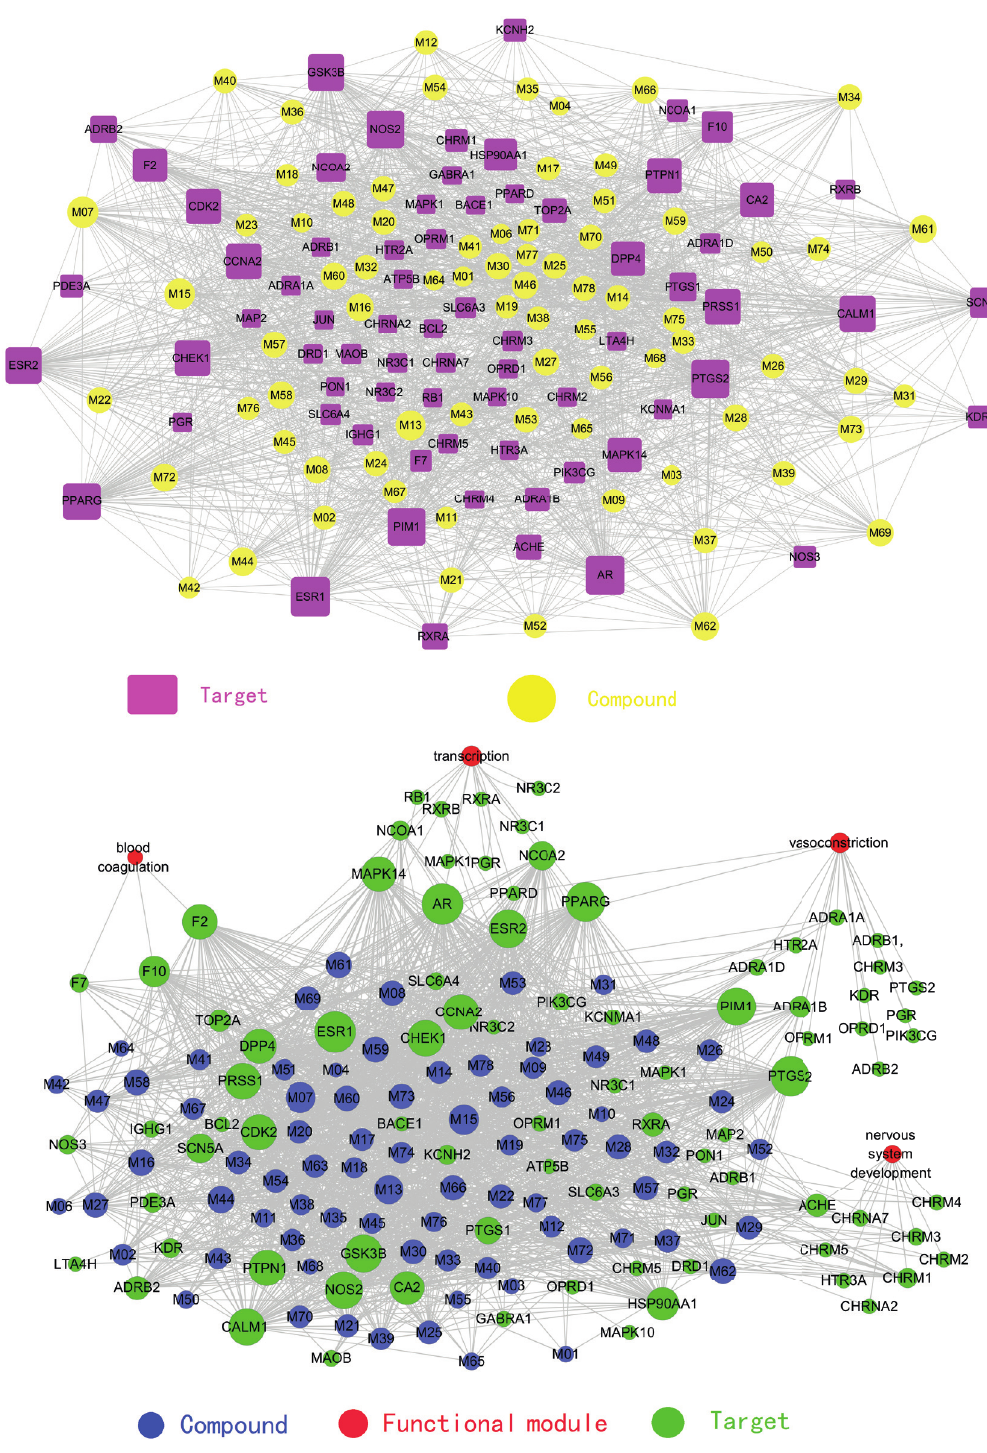
Figure 2 - a . Compound-target-function network. A compound and a target are linked if the target protein is hit by corresponding compound. Similarly, a target and a functional module are linked if the target is involved in this biological process. Node size is proportional to its degree and the letters are node labels. b . Compound-target relationship. A compound and a target are linked if the target protein is hit by the corresponding compound. Node size is proportional to its degree and the letters are node